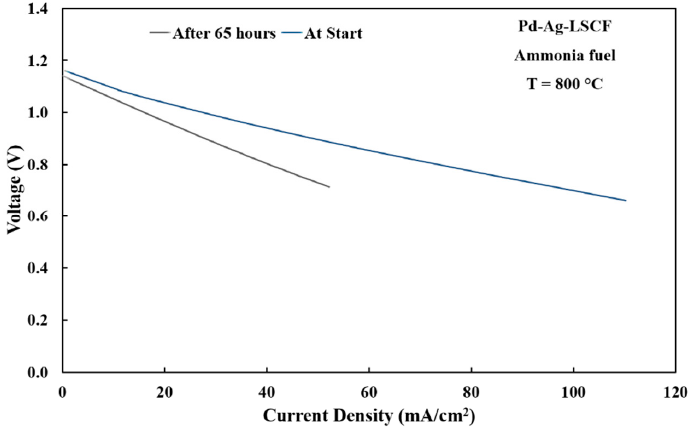
Figure 15. Voltage–current density characteristics of Pd-Ag-LSCF//YSZ//GDC/LSCF cell before and after 65 h of operation with ammonia fuel (ammonia = 50 mL/min, air = 75 mL/min) at 800 °C.